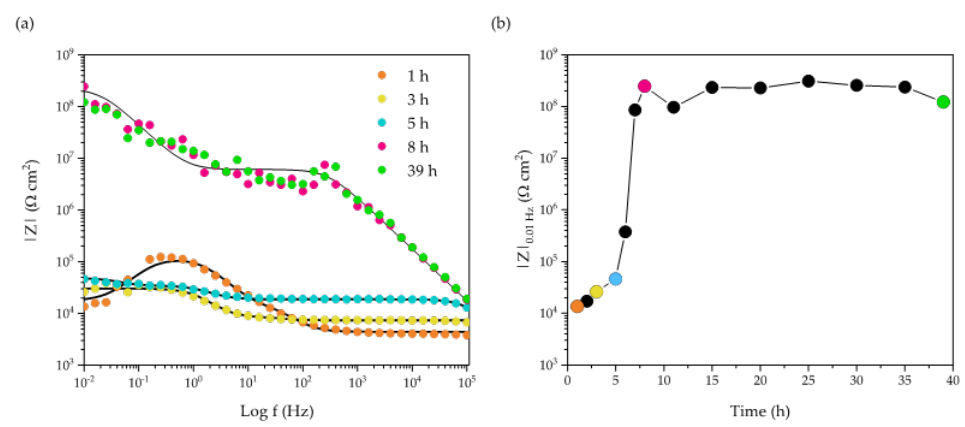
Figure 4. ( a ) Bode impedance spectra of a PPM copolymer coating with an artificial scratch upon exposure to 3.5% m/v NaCl solution. Dots represent experimental data and line are the fitting equations. ( b ) Evolution of |Z| 0.01Hz over exposure time; colors correspond to times reported in ( a ).